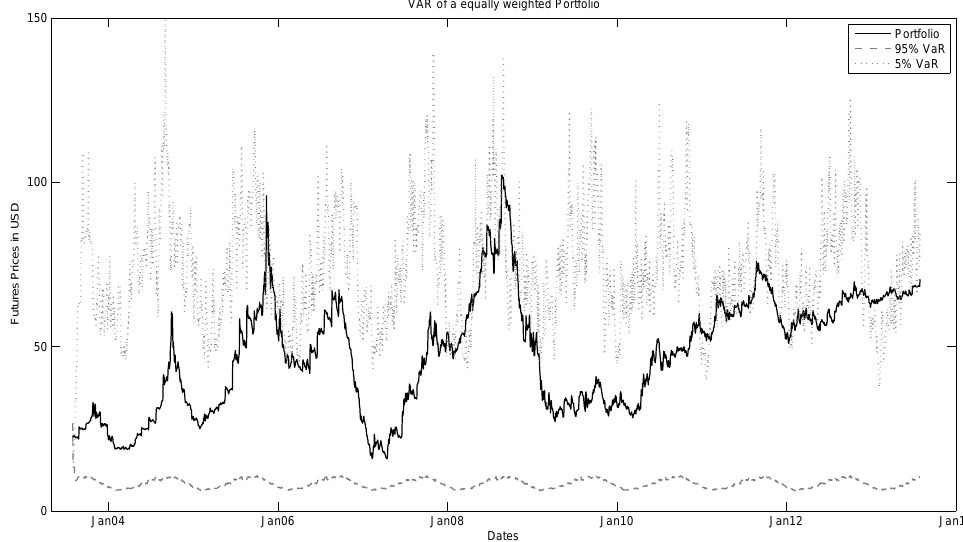
Figure 12. VaR for the ICE U.K. Natural Gas Futures estimated with the extended geometric